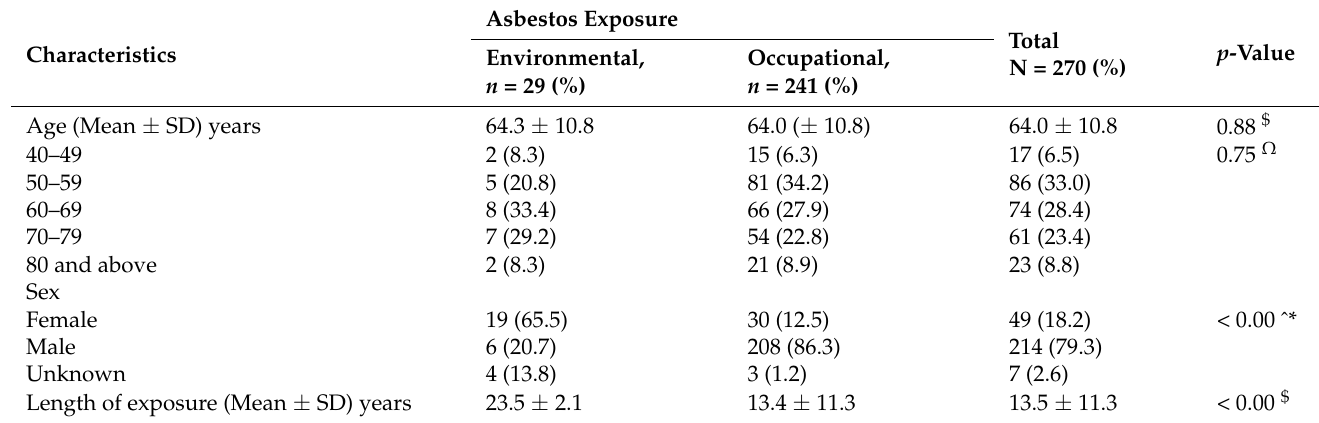
Table 1. Demographic characteristics, region, and annual mesothelioma diagnosis stratified by asbestos exposure.